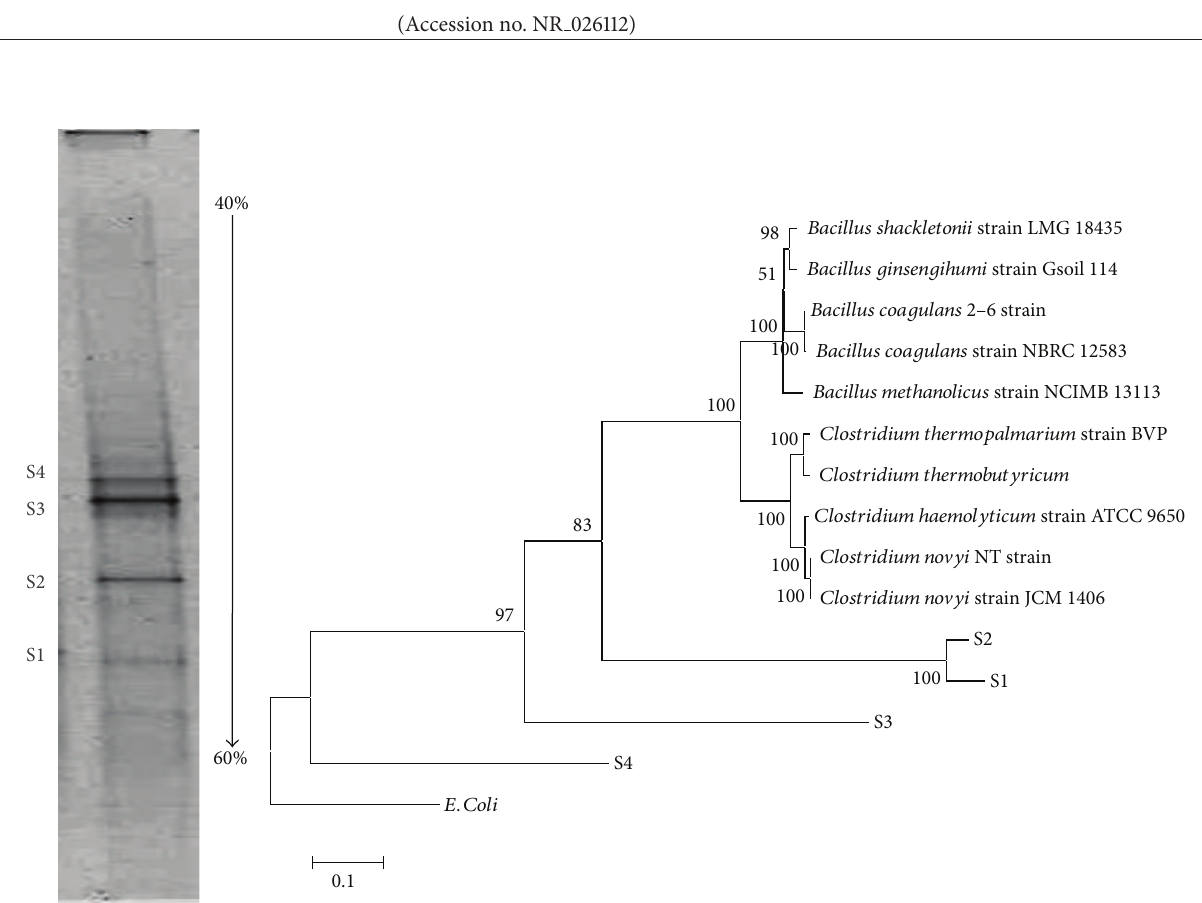
Figure 4: PCR-DGGE profile of the microbial community and Phylogenetic tree of the respective OTUs.